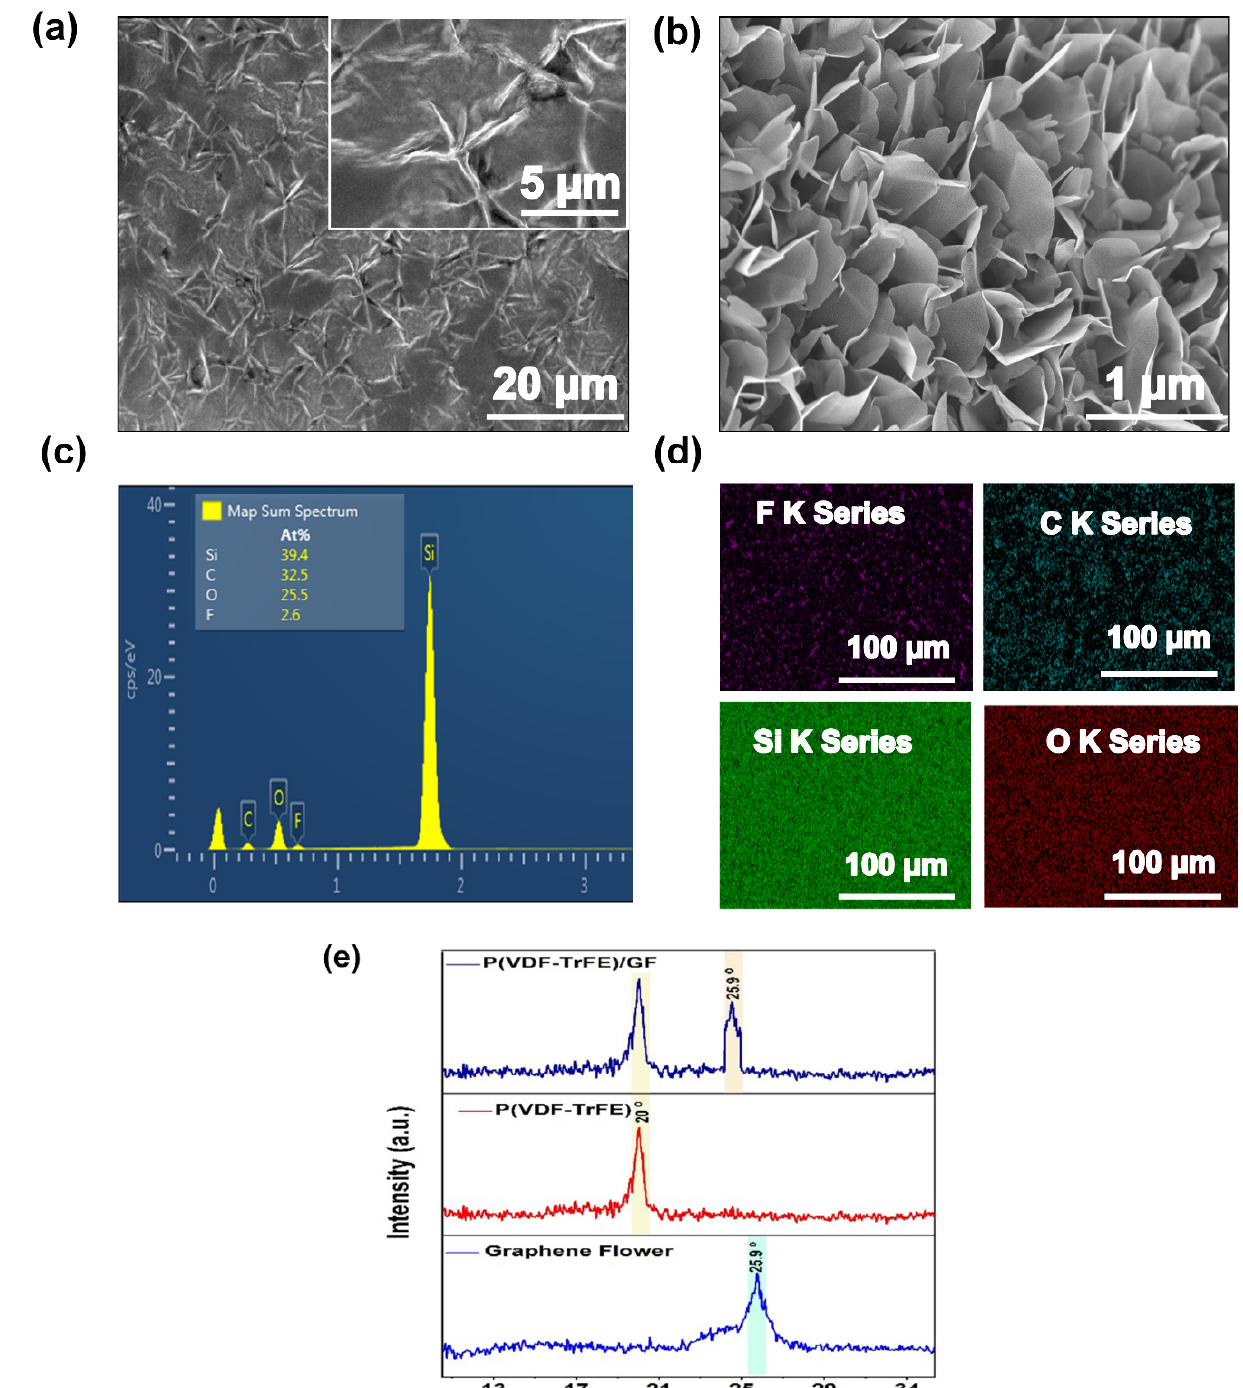
Figure 2. ( a ) SEM image of the deposited composite film P(VDF-TrFE)/GF composite film. ( b ) SEM image of GF. ( c ) EDS analysis of composite film showing the Si, C, O, and F elements in the active layer. ( d ) F K series, C K series, O K series, and Si K series. ( e ) XRD pattern of P(VDF-TrFE), GF, and their composite.